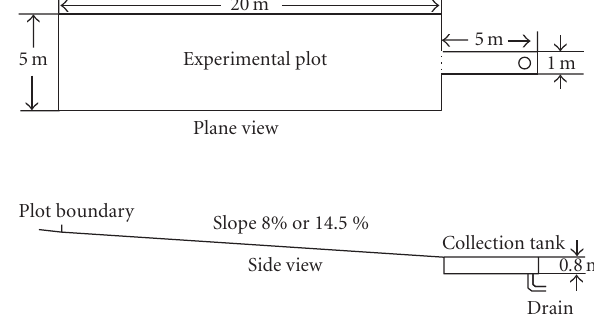
Figure 2: A scheme of the experimental